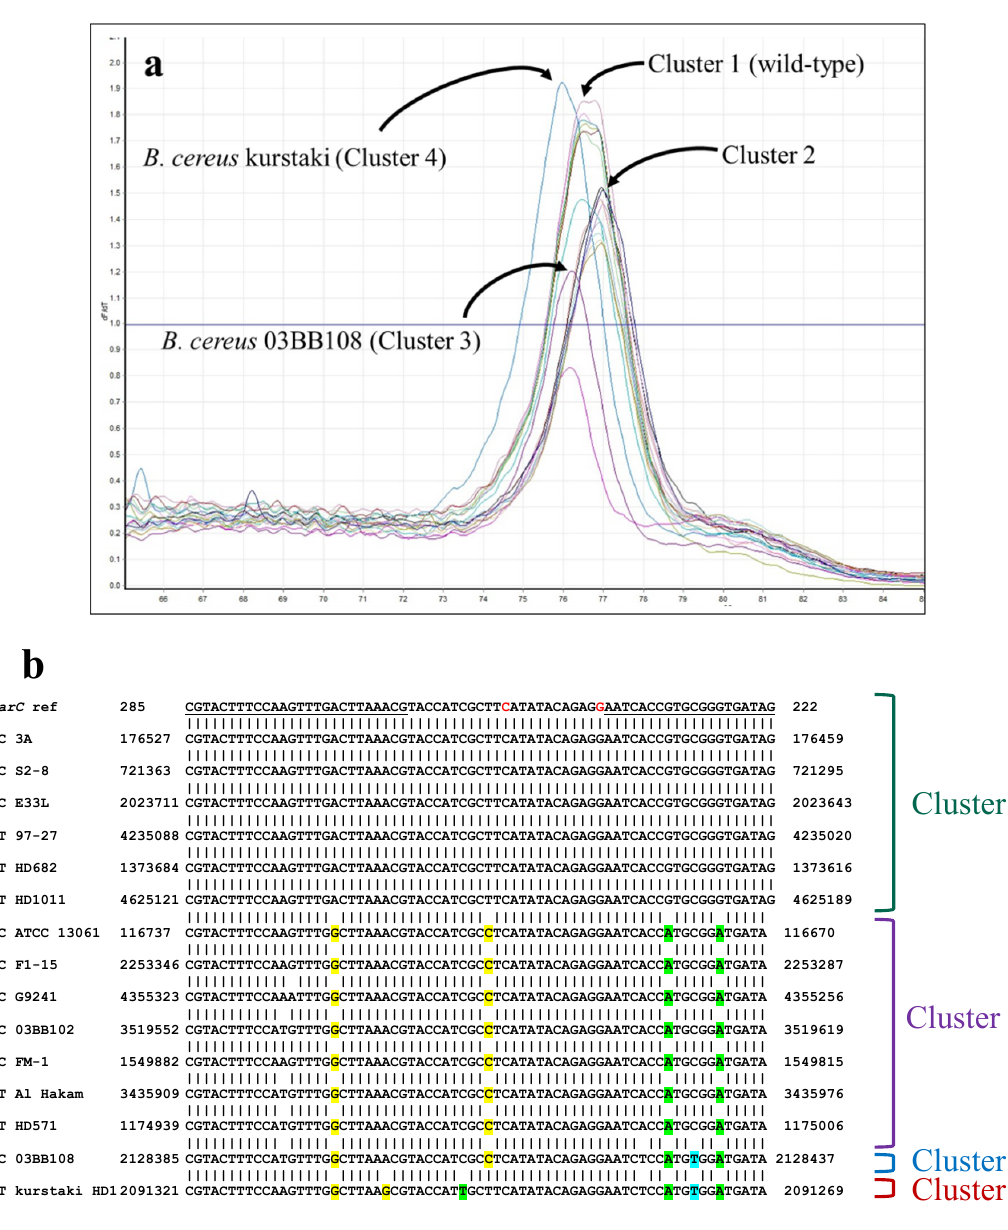
Figure 11. HRMA— B. cereus and B. anthracis parC . ( a ) Melt curves for B. cereus and B. thuringiensis parC amplicons. ( b ) Comparison of reference B. anthracis parC sequence with published sequences for the B. cereus (BC) and B. thuringiensis (BT) strains (see Table 12 for accession numbers). Primer sequences are underlined; mutations at the locations shown in red have been documented to cause fluoroquinolone resistance in B. anthracis . Substitutions predicted to increase or decrease amplicon T m s are highlighted in yellow or green, respectively.